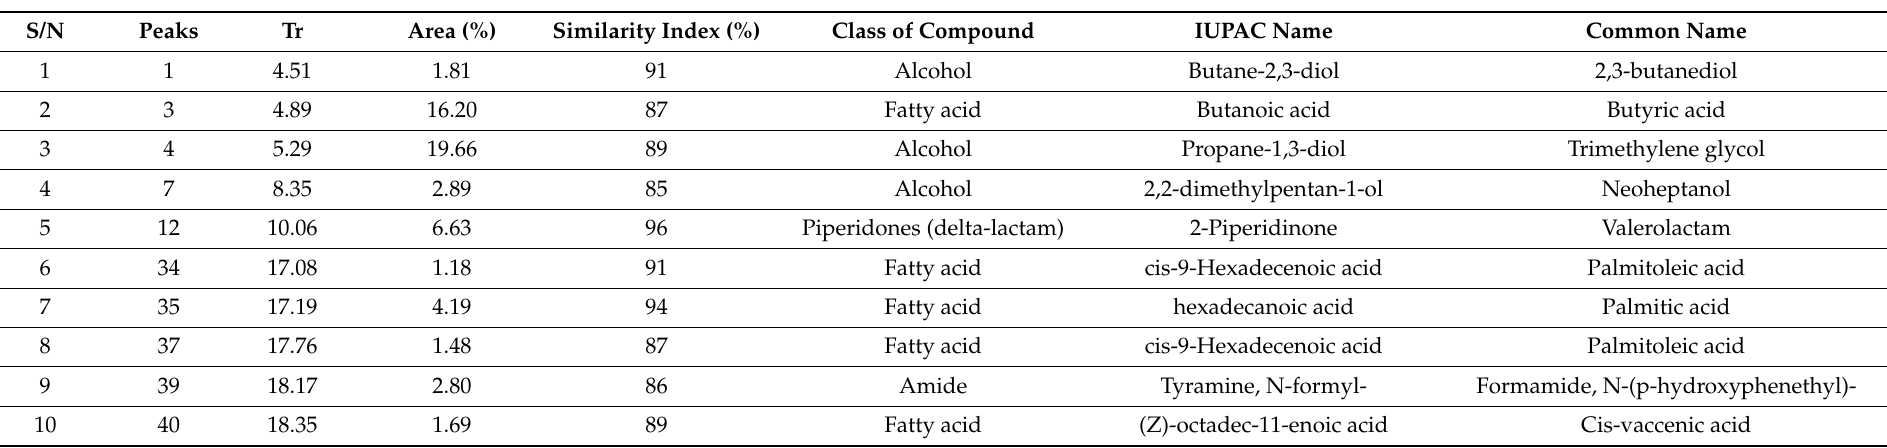
Table 4. Compounds present in the GC-MS analysis of the freeze-dried extract of fermented T. catappa